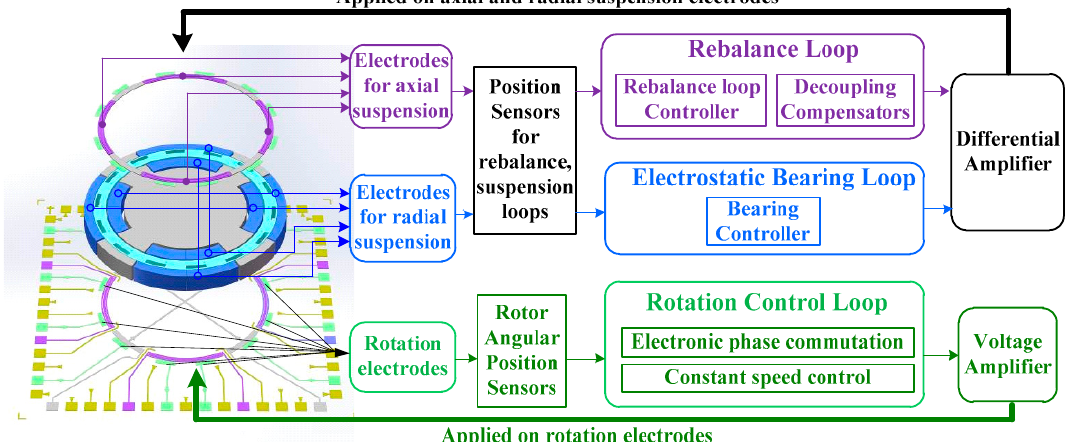
Figure 2. Block diagram of the control loop including rebalance loop, electrostatic bearing, and rotation